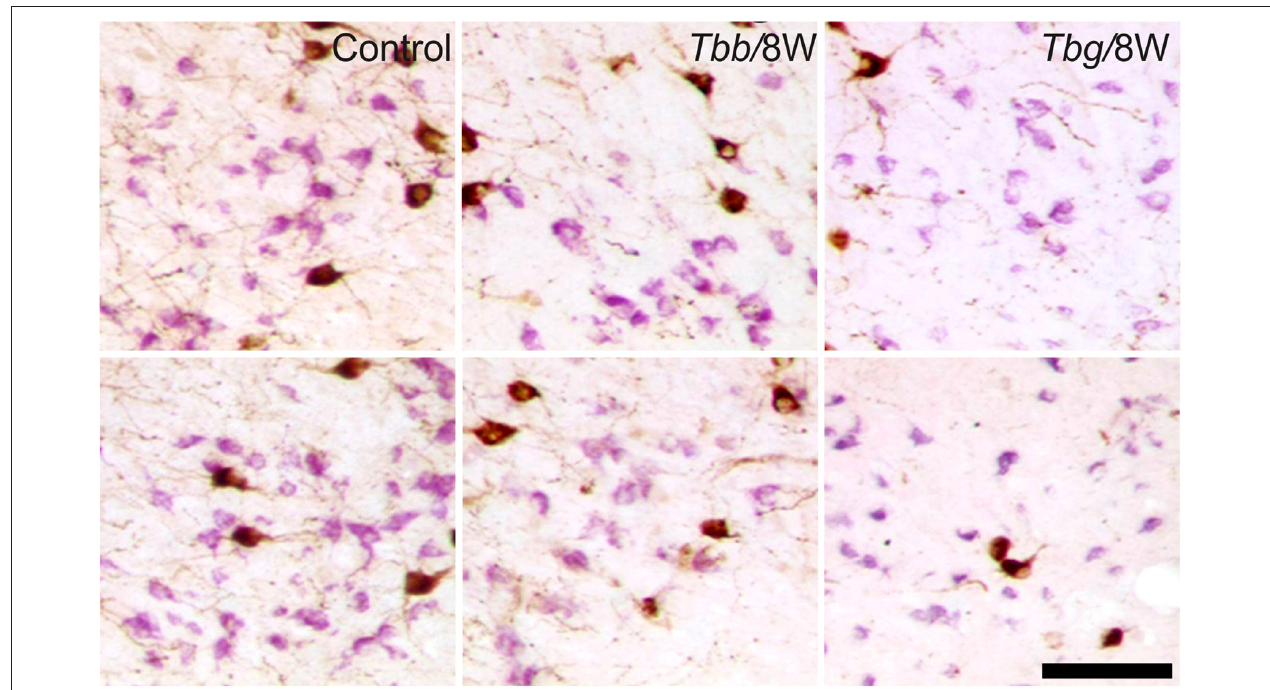
FIGURE 4 | Images of OX-A-immunoreactive neurons (brown) and melanin-concentrating hormone (MCH)-immunoreactive neurons (purple) through the middle third (upper row) and posterior third (lower row) of the lateral hypothalamus of uninfected Mastomys natalensis and at 8 weeks (W) after infection with Trypanosoma brucei brucei ( Tbb ) or Trypanosoma brucei gambiense ( Tbg ). Note the marked shrinkage of many MCH-immunostained neurons. Scale bar: 150 µ m.